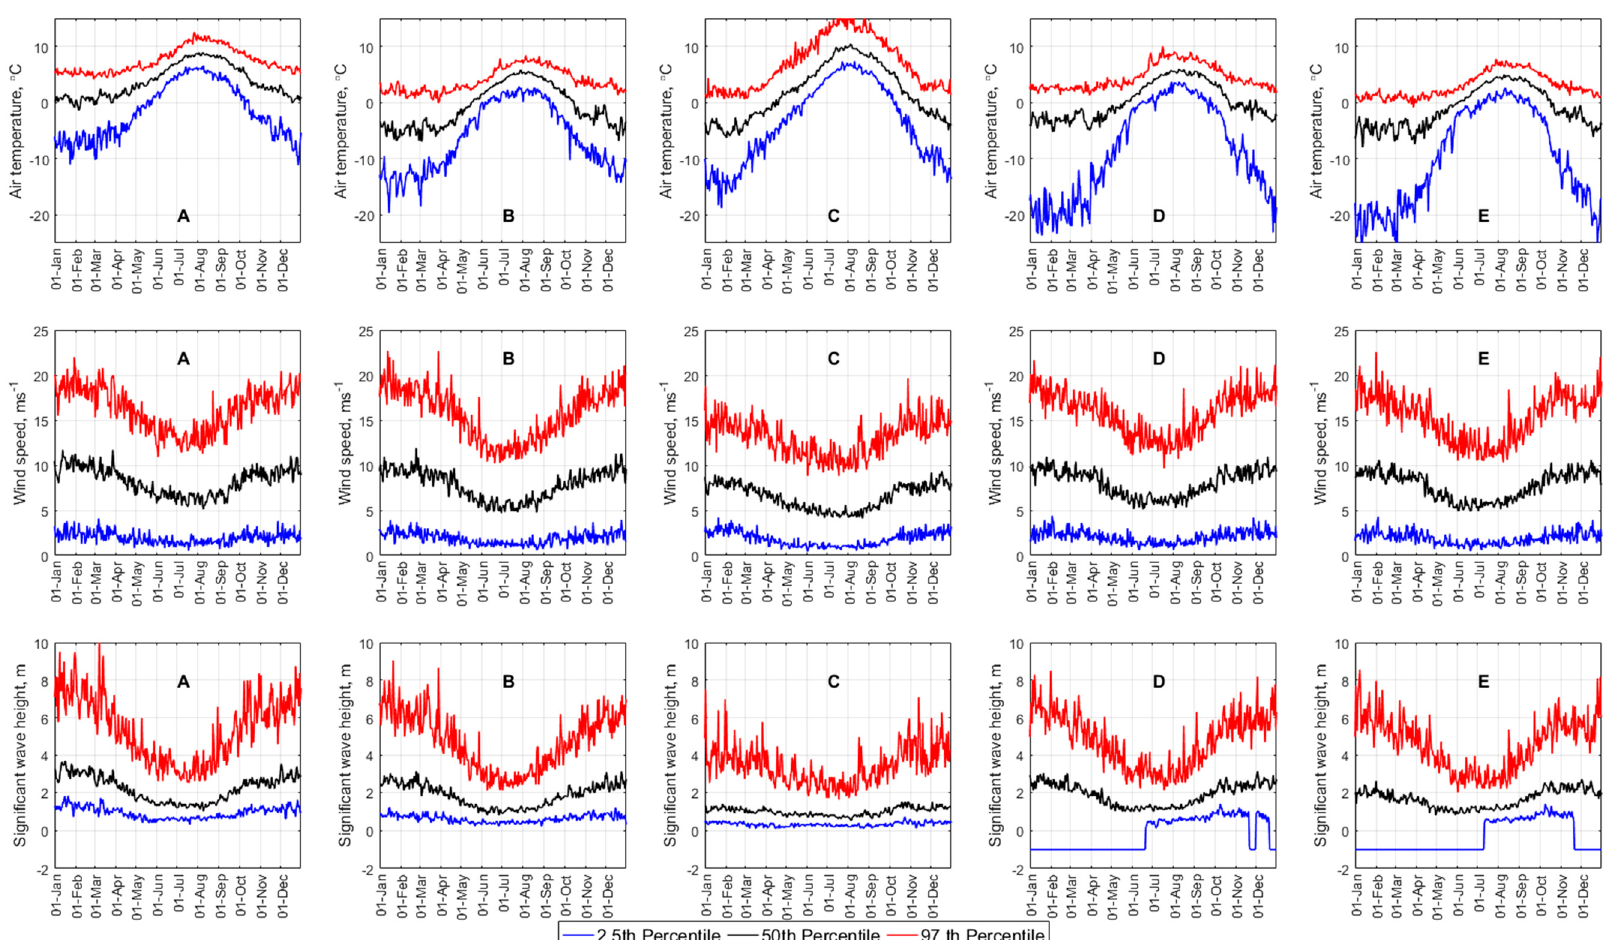
Figure 4. The 2.5th percentile (blue line), median (black line), and the 97.5th percentile (red line) of the daily variation of air temperature in °C, wind speed in m s − 1 , and significant wave height in ‘m’ in offshore locations A, B, C, D, and E.